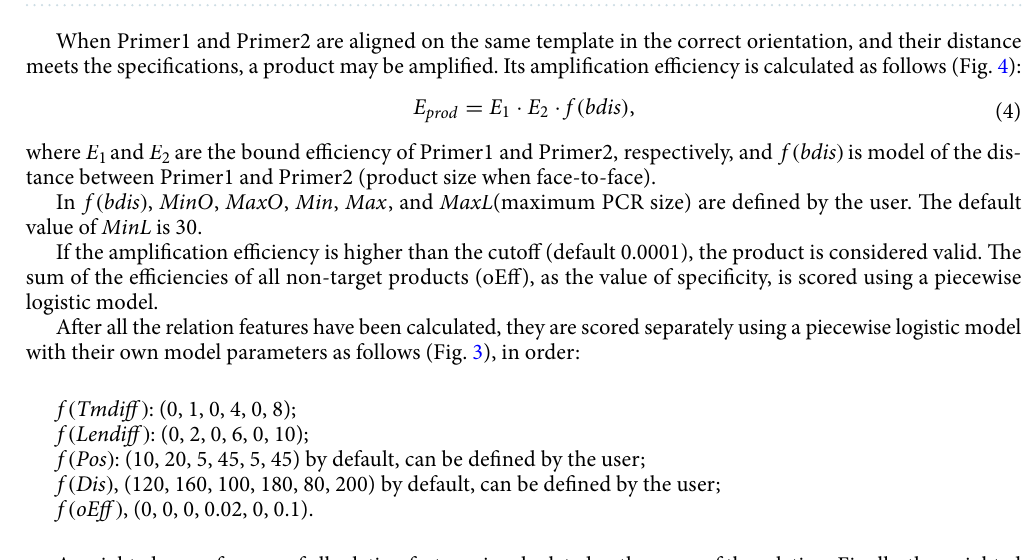
Figure 4. Several examples of the calculation of amplification efficiency of target and non-target products for three kinds of orientation. The factors affecting the amplification efficiency of products are primarily the bound Tm, mismatches (both number and distance to the 3 ′ end of the primer), and the distance between Primer1 and Primer2 (product size when face-to-face). Two or three examples of each factor were given. The schematic efficiency of each product example ( E prod ) was shown, and the product is amplified only when the efficiency is more than